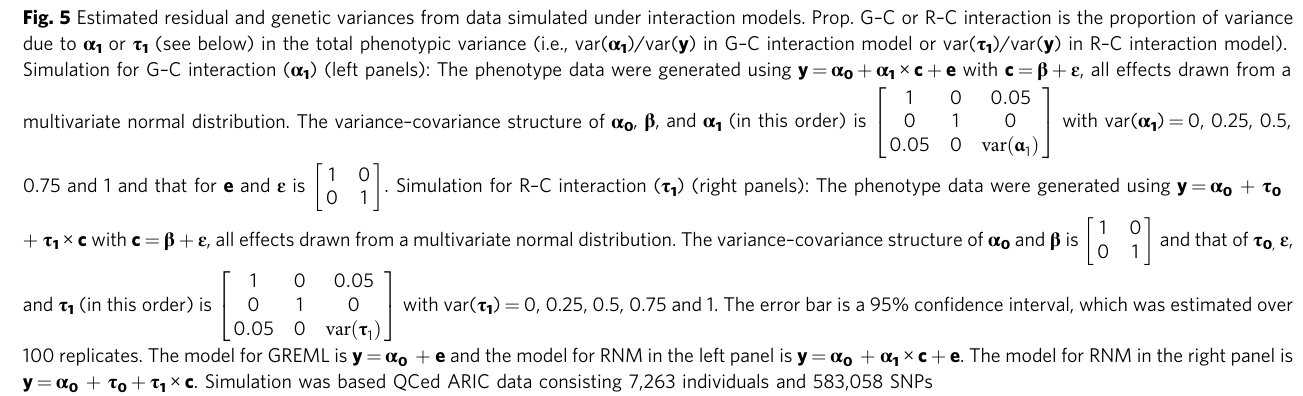
100 replicates. The model for GREML is y = α 0 + e and the model for RNM in the left panel is y = α 0 + α 1 × c + e . The model for RNM in the right panel is y = α 0 + τ 0 + τ 1 × c . Simulation was based QCed ARIC data consisting 7,263 individuals and 583,058